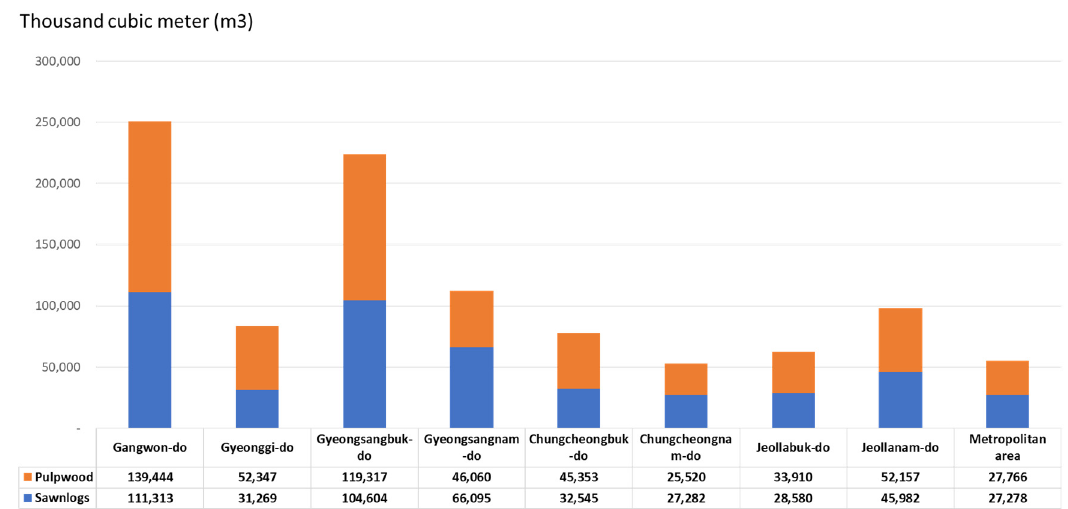
Figure 4. Estimated national ‐ level forest resource availability in thousands of cubic meters.